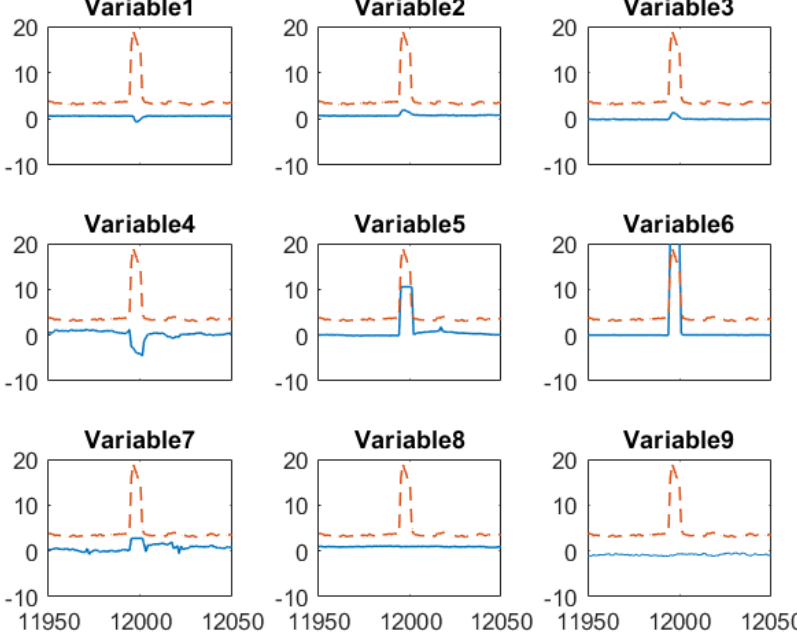
Figure 8. Mean-centered and scaled input variables (--) of the software sensor and soft sensor predicted impurity ( ─ ) around when the true alarm occurs. impurity (–) around when the true alarm